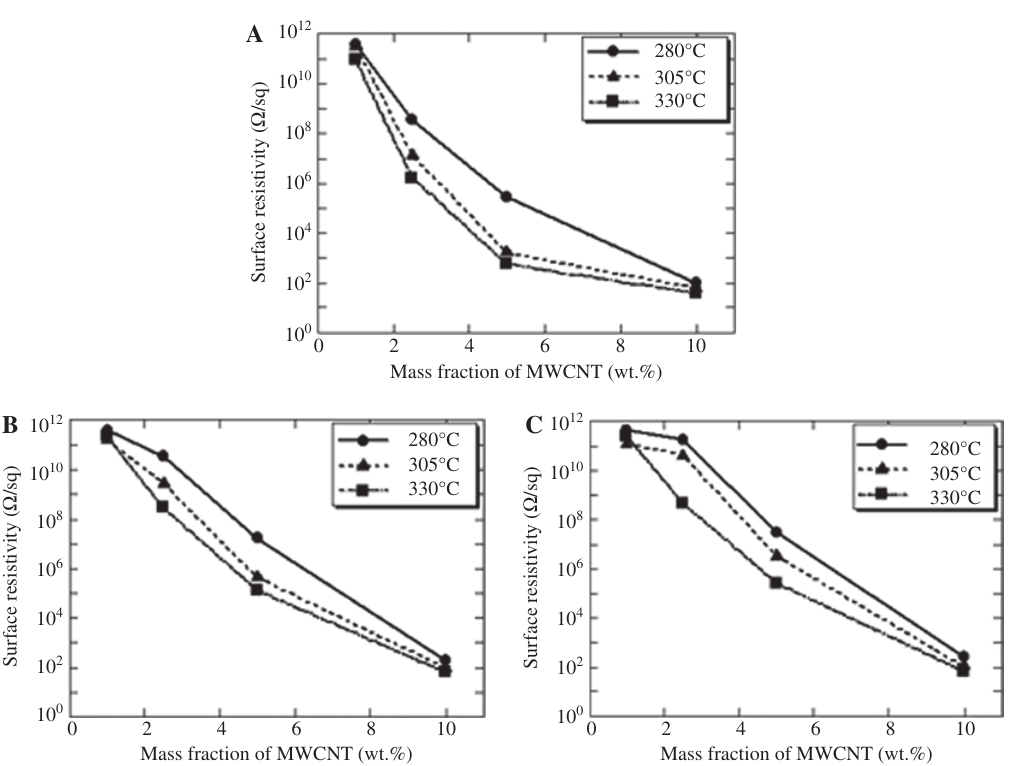
Figure 5: Effect of MWCNT mass fraction on the surface resistivity of the MWCNT/PC composites obtained at injection speeds of (A) 10 mm/s, (B) 40 mm/s, and (C) 80 mm/s,